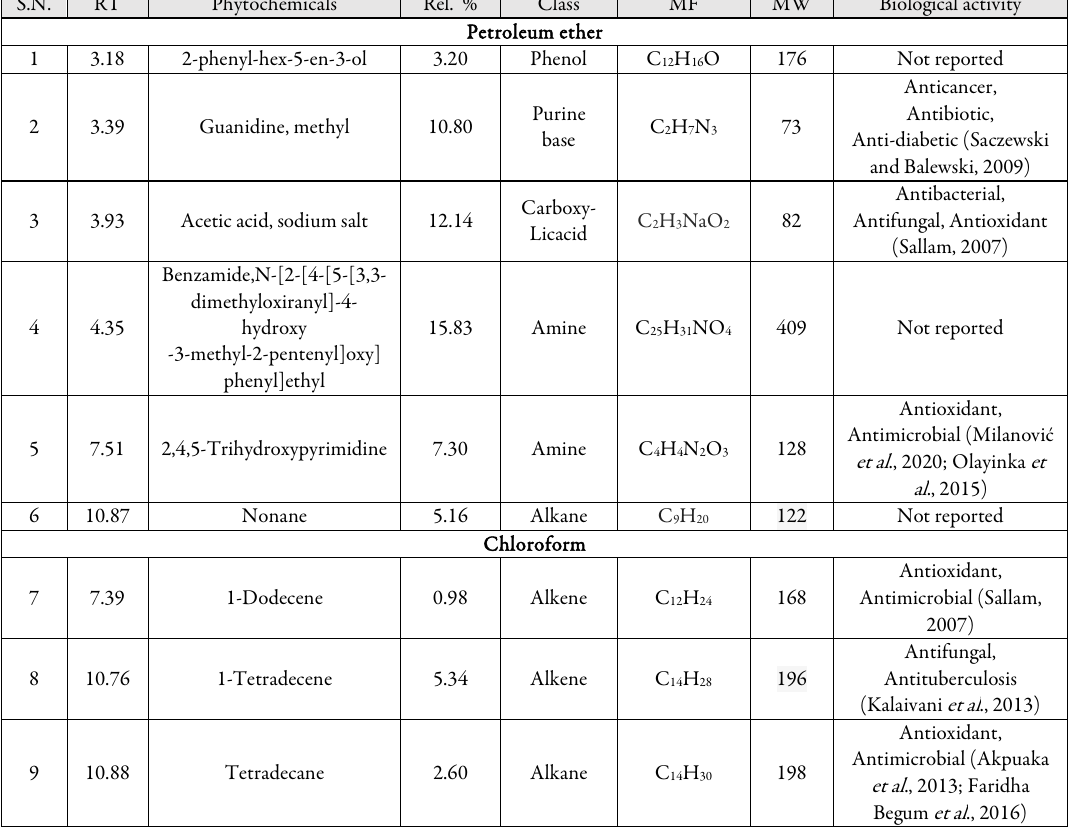
Table 3. Bioactive compounds identified in different solvent extract of Mucuna pruriens (L.). DC. leaves